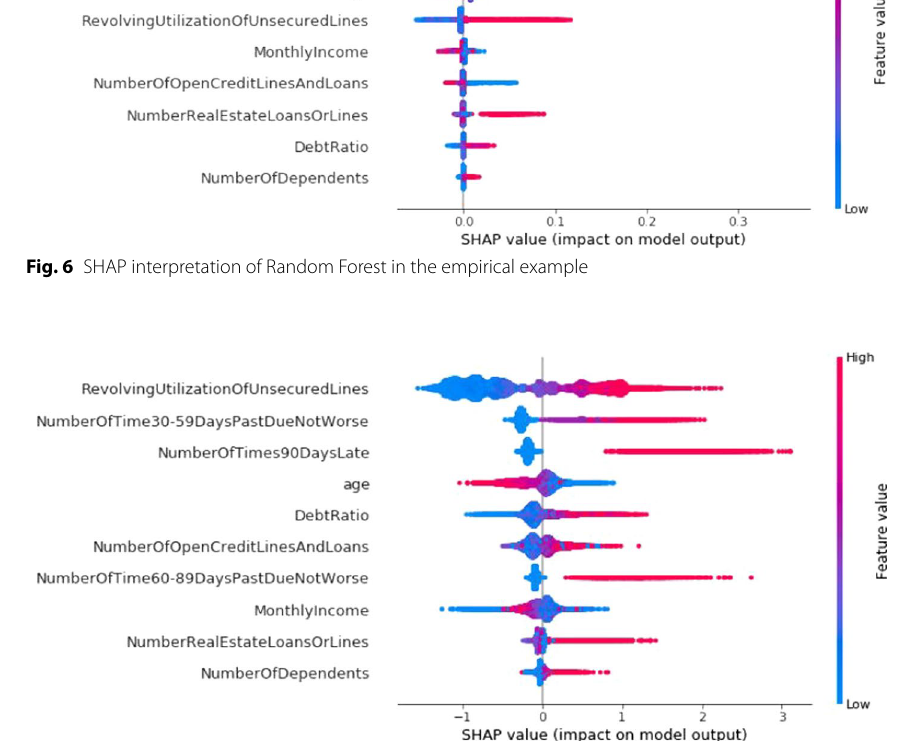
Fig. 7 SHAP interpretation of XGBoost in the empirical